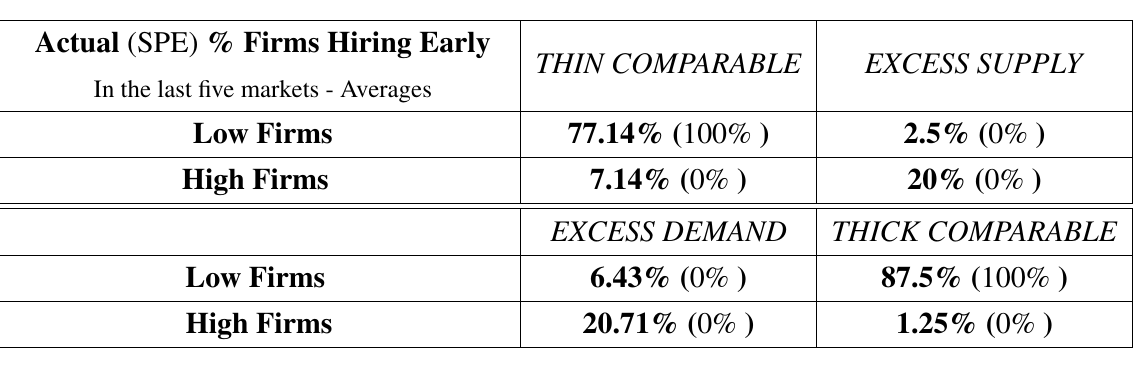
Table 6. Average percentage of firms hiring early in the last five markets, with subgame perfect equilibrium predictions in parentheses.